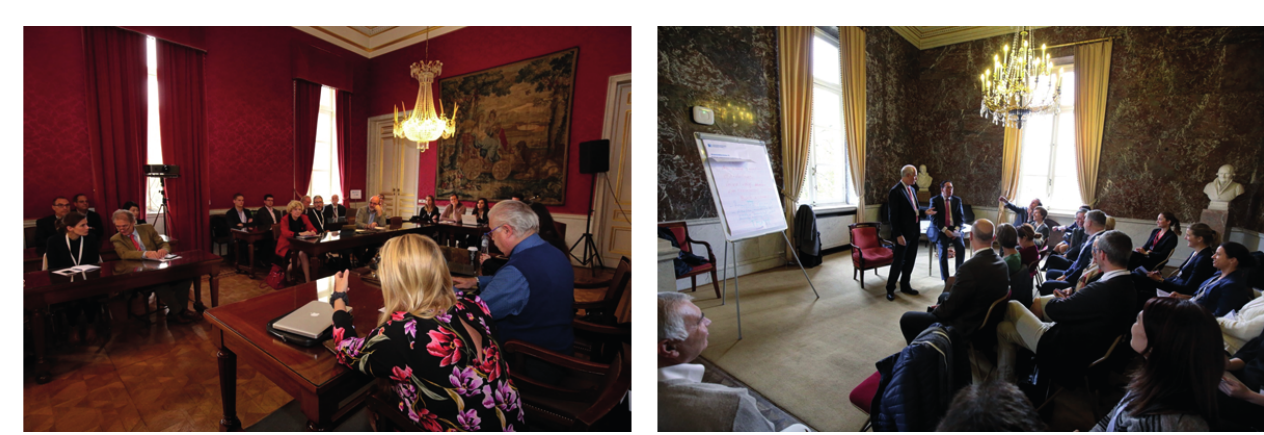
Figure 1. Impressions of the brainstorming